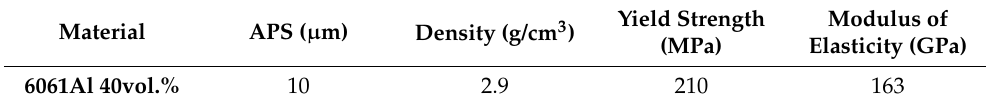
Table 1. Machining properties of 40 SiCp/Al.